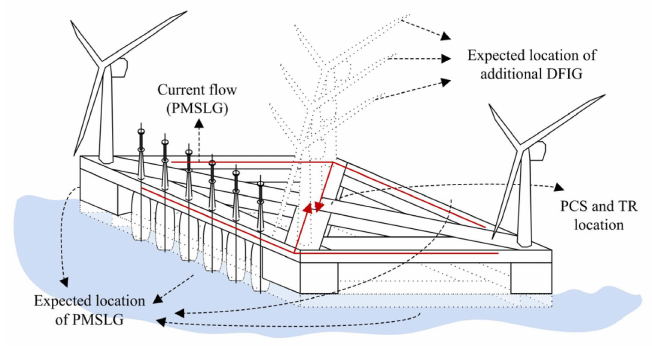
Figure 2. Concept of the wave-offshore hybrid generation system. TR: transformer.